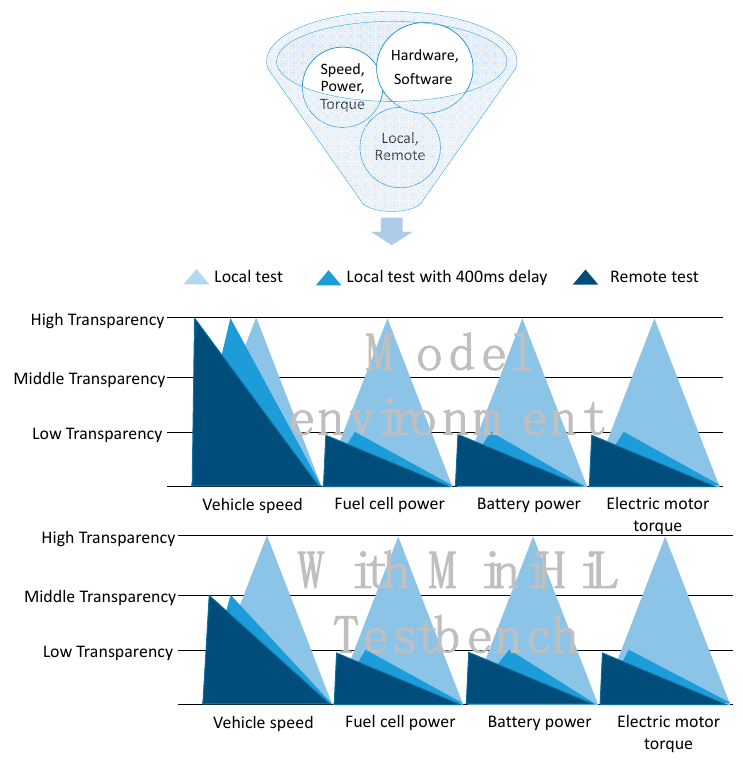
Figure 18. Summary of transparency types (high, middle, and low) under different configurations.